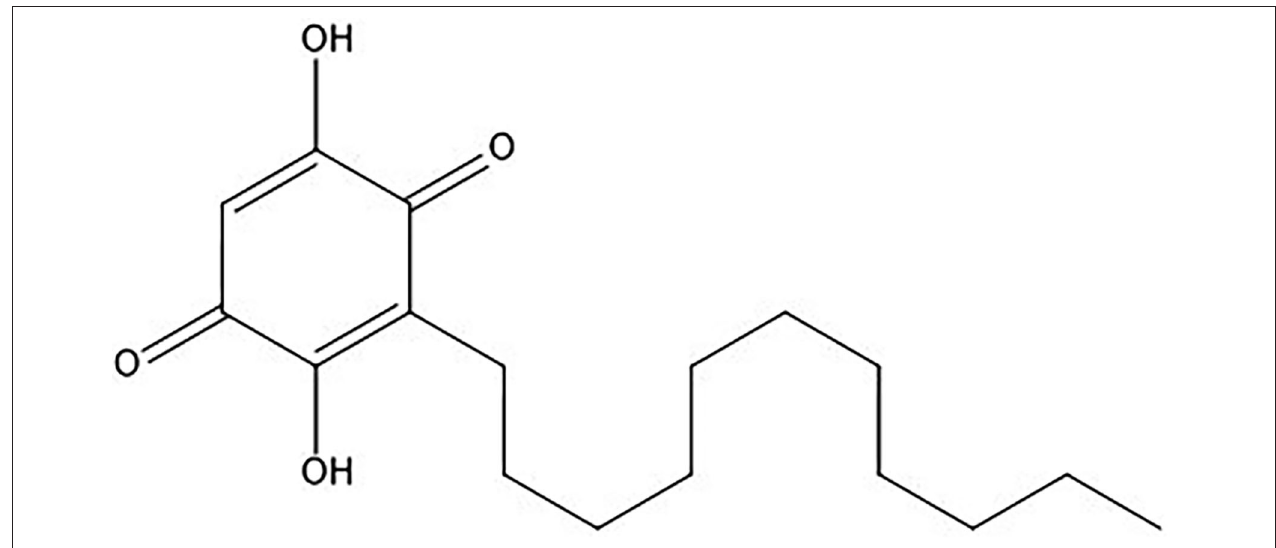
FIGURE 1 | Chemical structure of